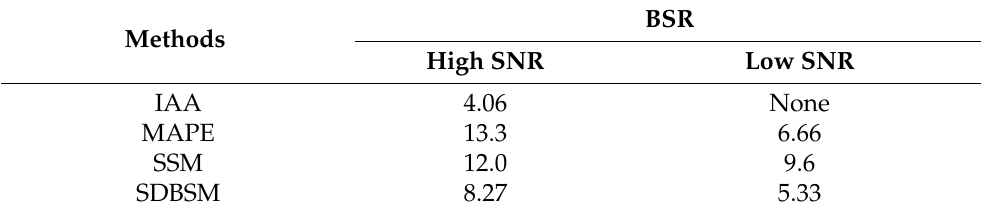
Table 1. BSRs of different methods.